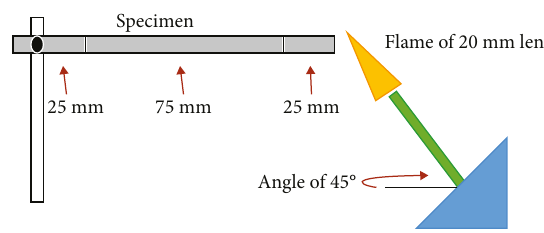
Figure 2: Flammability UL 90 HB test schematic.